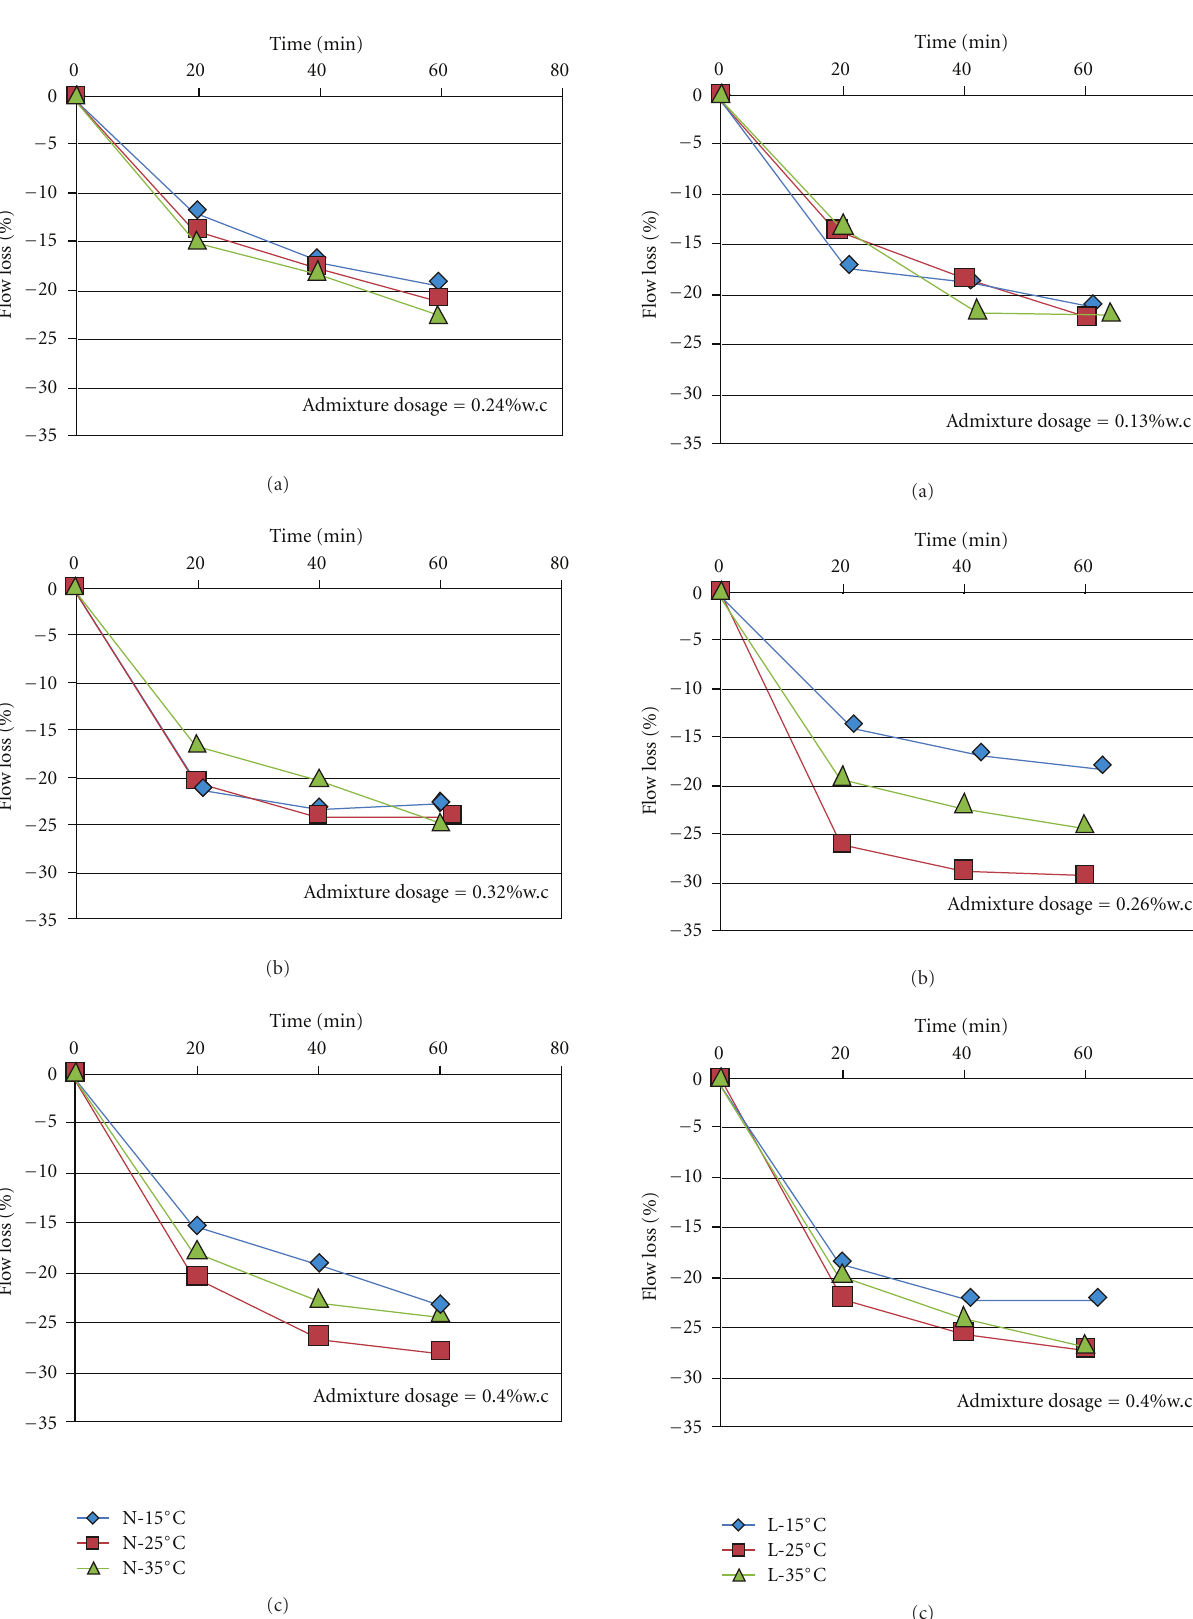
Figure 8: E ff ect of temperature variation on flow